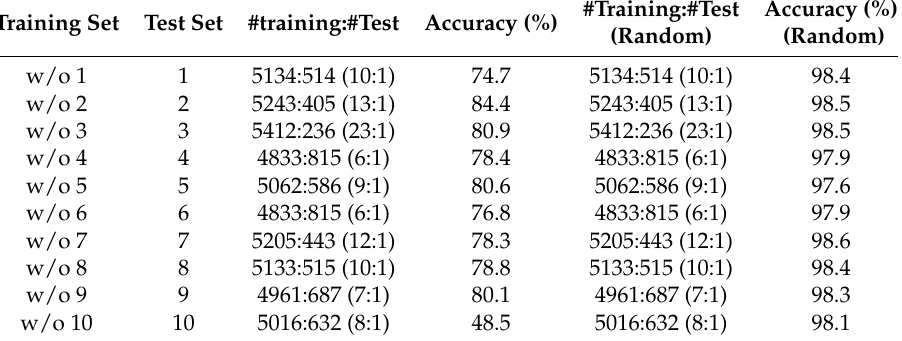
Table 6. Left : the dataset was split into training and test set according to the date of acquisition. In each experiment, images taken from a single date were chosen as test set while the others images as training set. Right : randomly sampled training and test sets. #training:#test denotes the ratio of the number of training images to the number of test images.